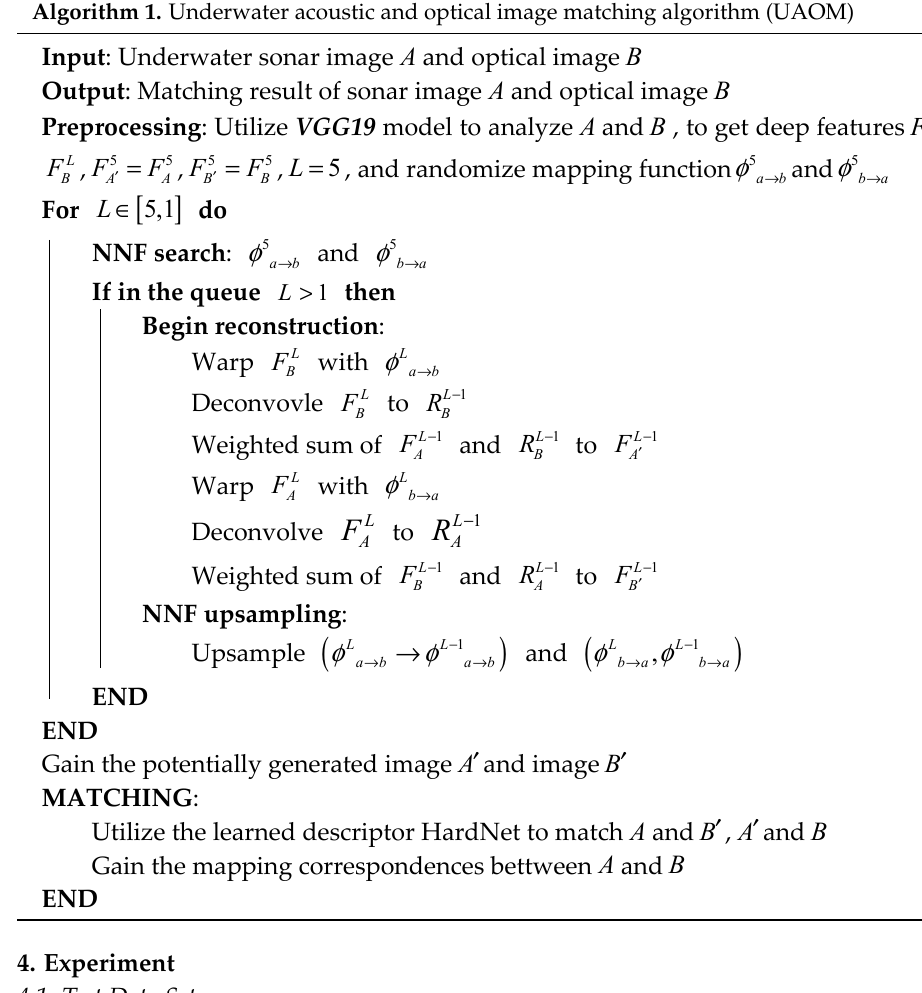
Algorithm 1. Underwater acoustic and optical image matching algorithm (UAOM)